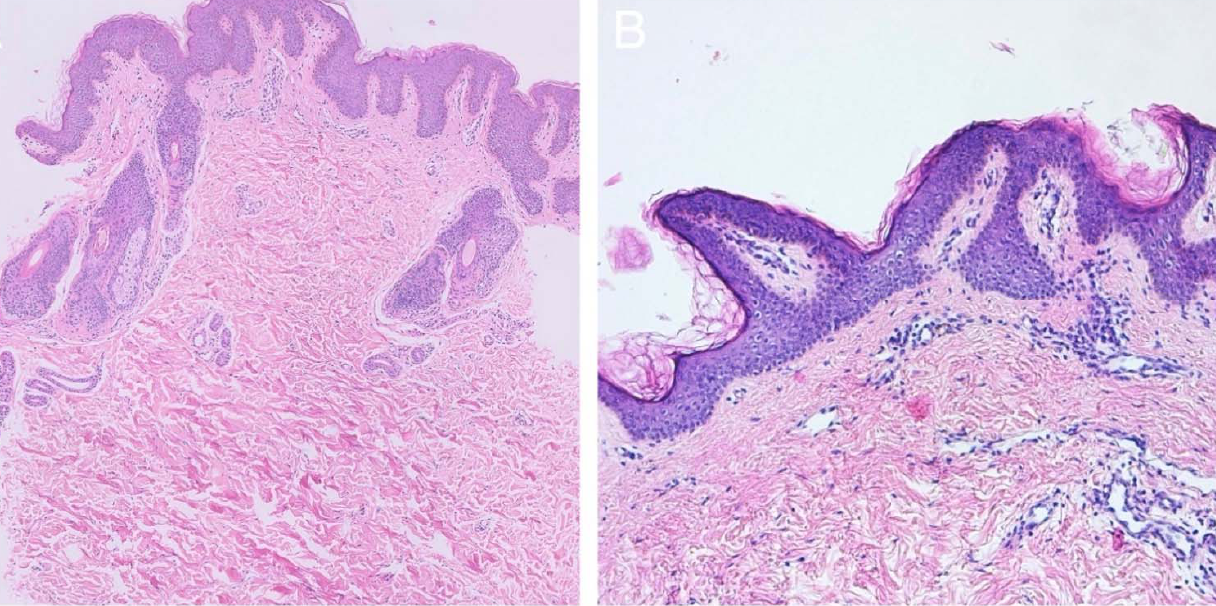
Figure 2. ( A – D ) Histopathology . ( A ) A skin biopsy from the slightly palpable Blaschkoid hyperpigmentation on the right arm in individual 1 shows features suggestive of epidermal nevus, including discrete acanthosis, hyperkeratosis and pigmentation of the basal layer (magnification ×100). ( B ) Similarly, epithelial hyperplasia and papillomatosis confirm the diagnosis of epidermal nevus on the chin of individual 2 (magnification ×400). ( C , D ) A skin biopsy taken in the focal region of alopecia in individual 1 shows the presence of fat in the dermis, tissue fibrosis and an anagen arrest of hair follicles, indicative of nevus psiloliparus (magnification ×100). In individual 2, a skin biopsy from the lesion in the neck showed papillomatosis with accompanying seborrheic epithelial hyperplasia and the presence of two inclusion cysts, suggestive of the diagnosis of EN (Figure 2B). 2.3. Molecular Genetic Testing